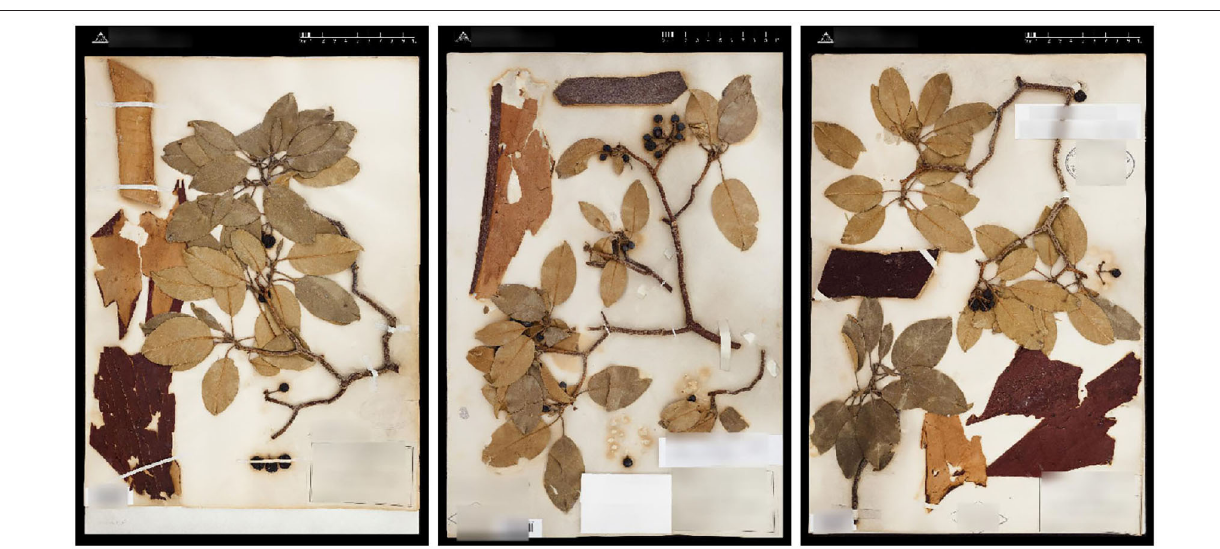
FIGURE 4 | Different specimens of Arbutus xalapensis Kunth (Ericaceae) made from the same individual plant at the same time by the same collector using the same pressing, drying, and mounting protocol.